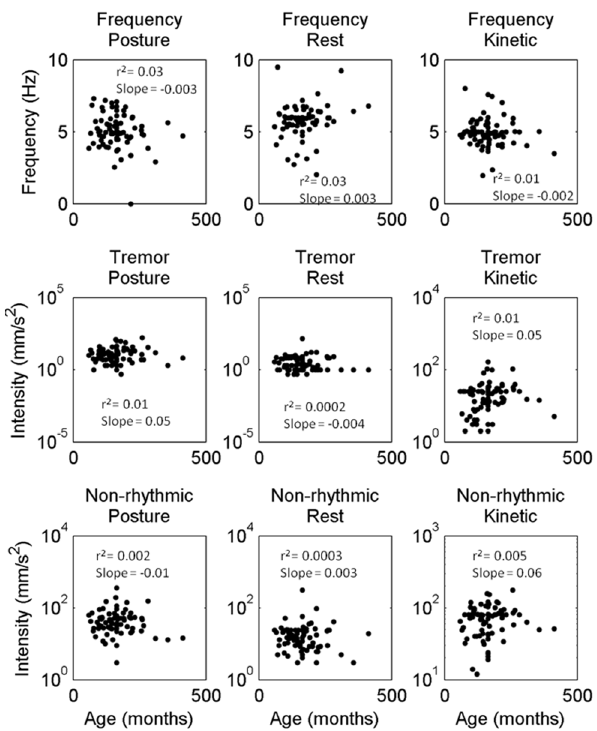
Figure 6. Correlation of frequency, tremor and non-rhythmic movement amplitude during postural, resting, and kinetic condition with subject’s age. Frequency, tremor and non-rhythmic movements during postural, resting, and kinetic conditions are plotted versus the subjects’ age in months. Slope and correlation coefficient by linear regression are depicted in the inset of each subplot. None of these parameters revealed any correlation.